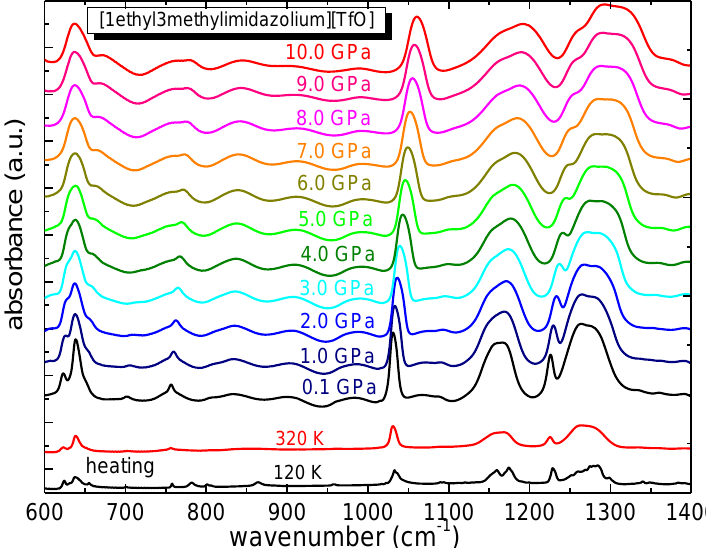
Figure 3. Absorbance of EMI–TfO in the mid infrared range measured at room temperature as a function of pressure. For comparison, two spectra recorded as a function of the temperature on heating in the same frequency range are reported in the lower part of the figure.